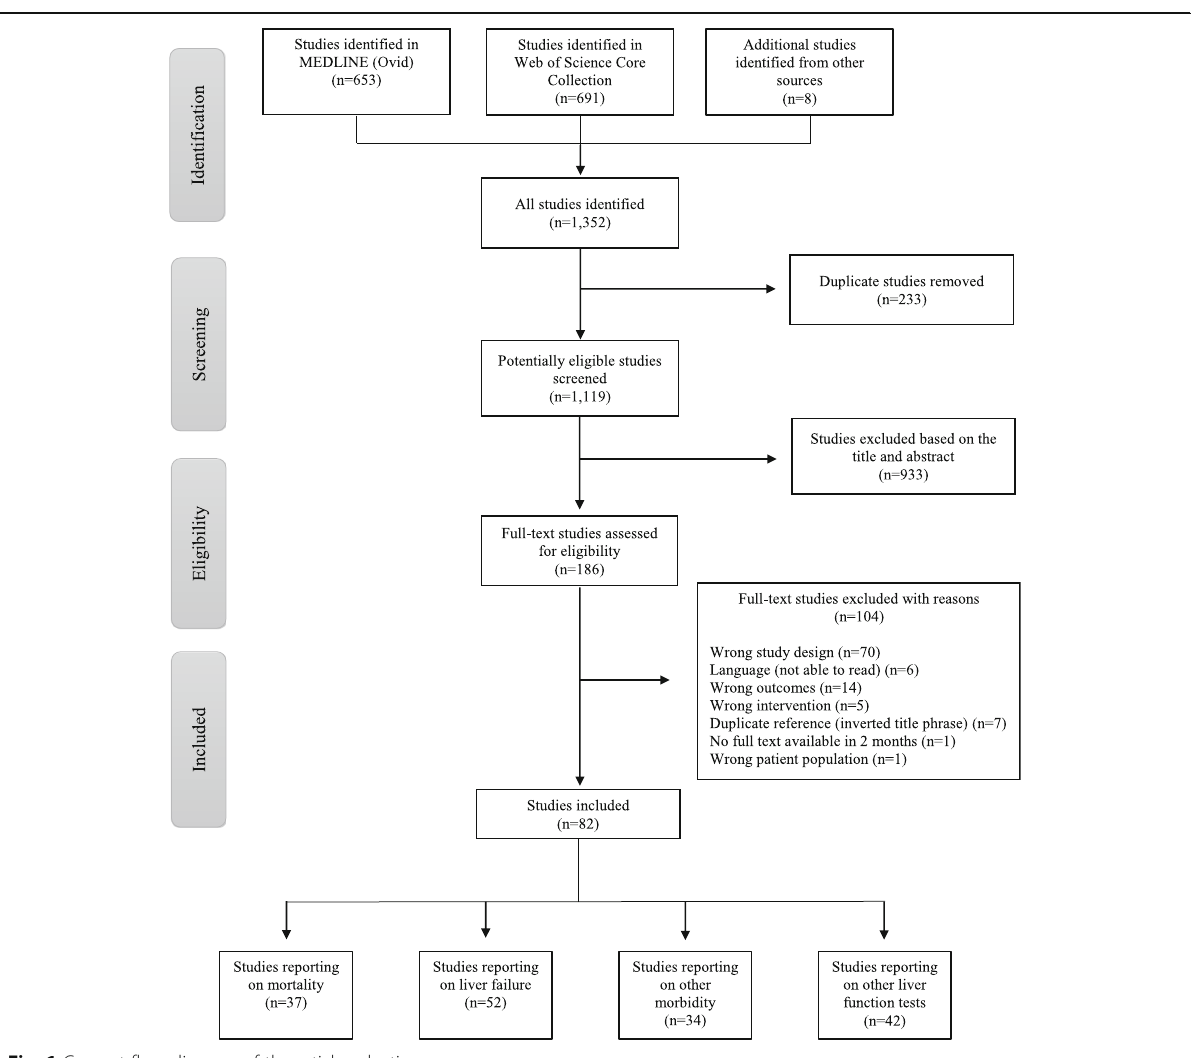
Fig. 1 Consort flow diagram of the article selection